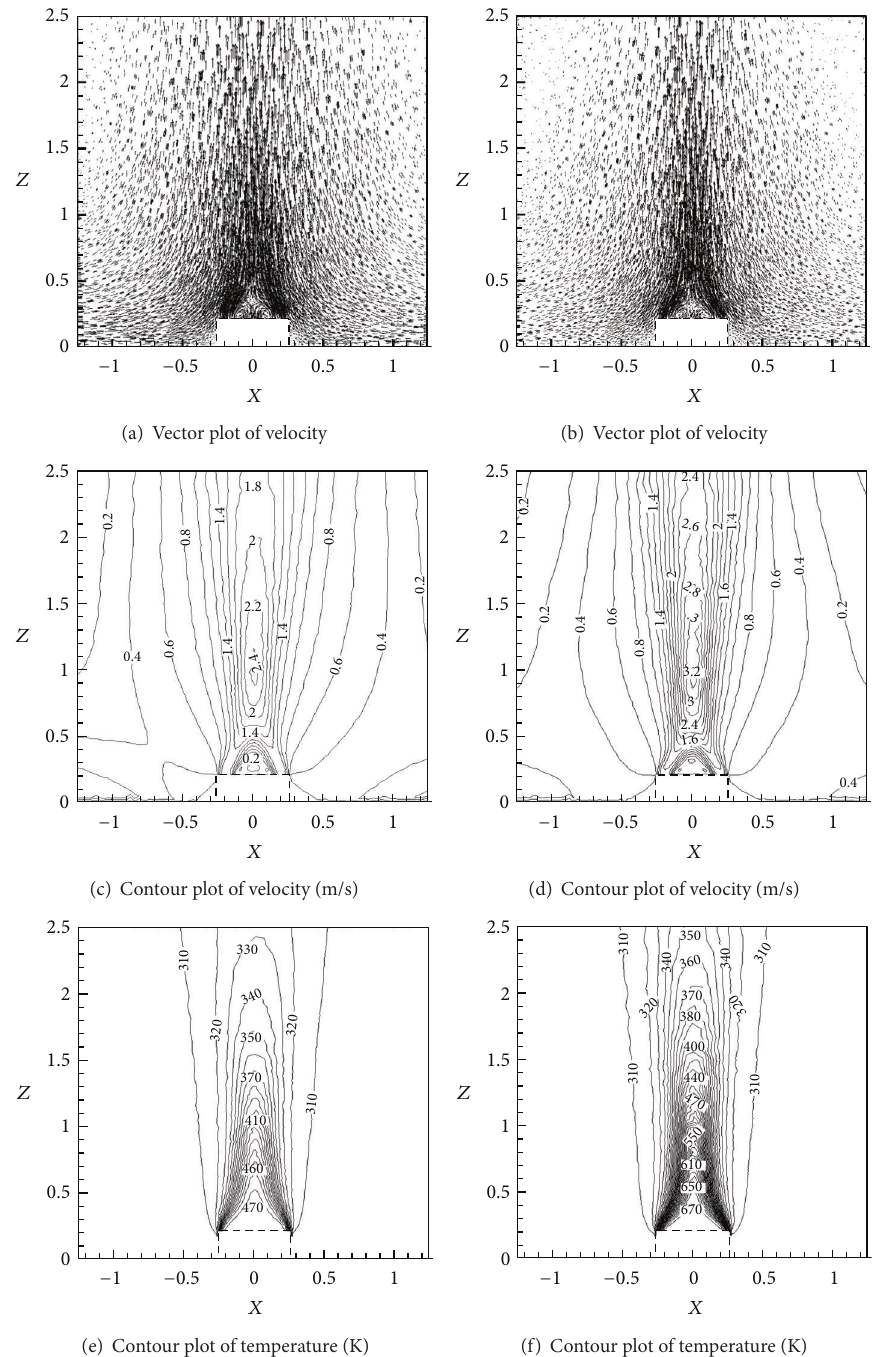
Figure 9: Comparison of velocity and temperature field between Case 2 ( 𝑈 0 = 1.2 m/s, 𝑡 0 = 200 ∘ C) and Case 3 ( 𝑈 0 = 1.2 m/s, 𝑡 0 = 400 ∘ C).